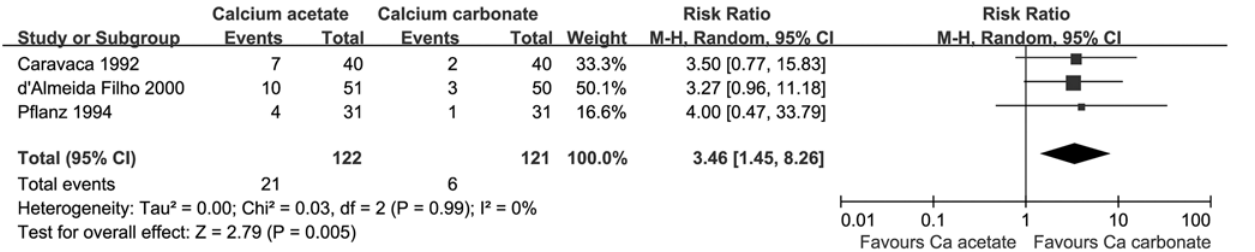
Fig 6. The incidences of drug intolerance in calcium-based phosphate binder